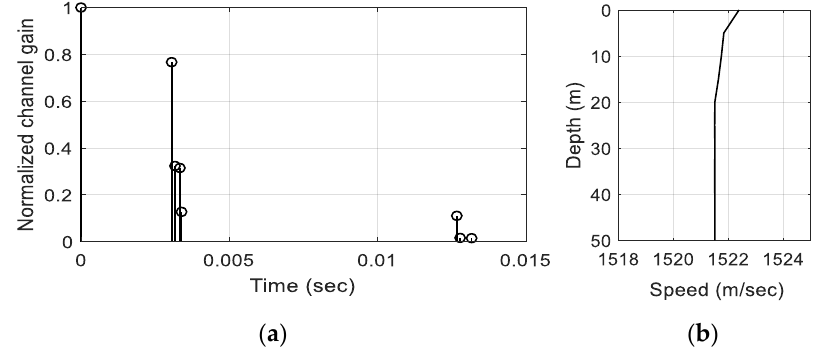
Figure 9. Simulation channel ( a ) delay profile, ( b ) sound velocity profile (SVP).